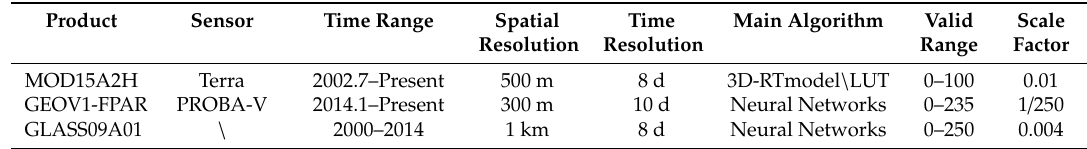
Table 2. The mean characters of fraction of absorbed photosynthetically active radiation (FPAR)